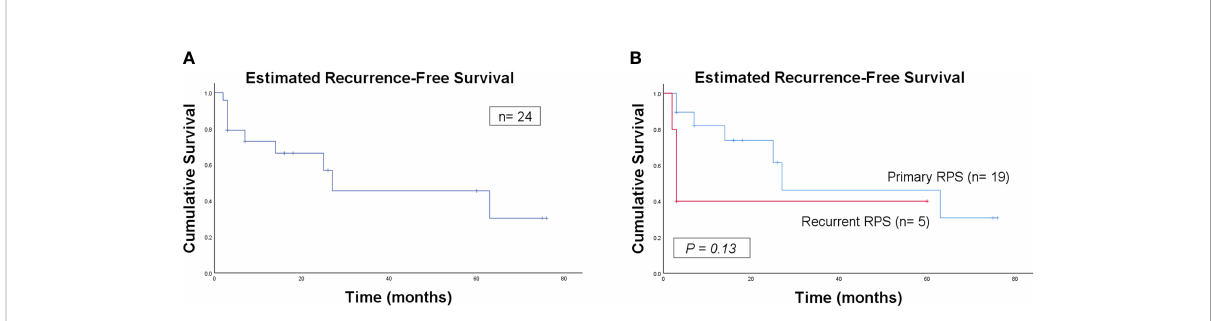
FIGURE 5 Kaplan – Meier curve of estimated recurrence-free survival for all the patients (A) and for comparison of primary and recurrent patients (B)